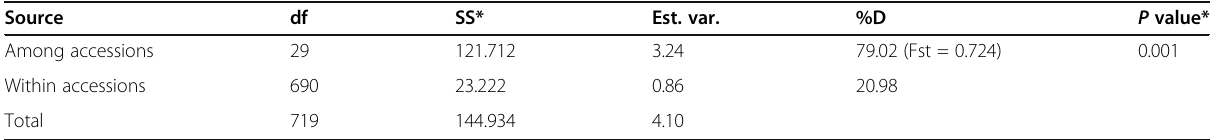
Table 5 AMOVA for 30 sweet sorghum accessions using 24 TRAP marker combinations